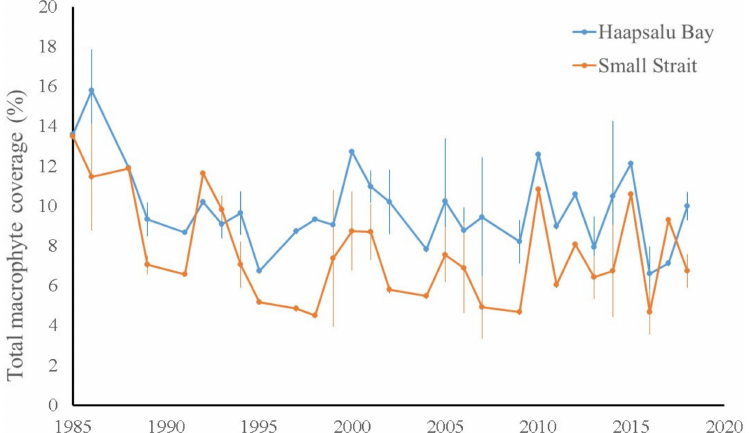
Figure 6. Changes in areal benthic macroalgal cover (measured in percentages) ± standard error in Haapsalu Bay and Small Strait in the period of 1985 − 2018.